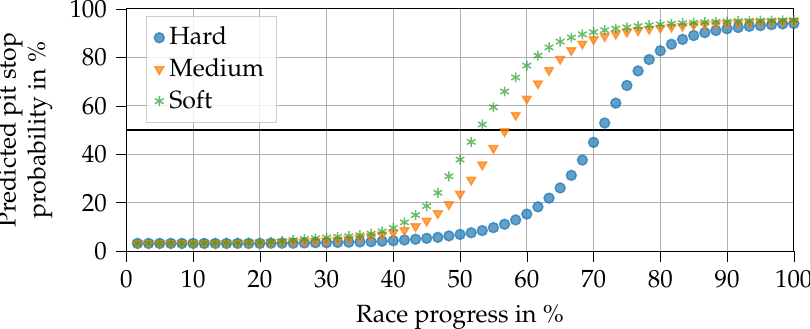
Figure 9. Progressions of pit stop probability predictions in an exemplary race when varying the relative tire compound, as outputted by the final trained hybrid NN. The horizontal line at a 50% probability level separates the no pit stop from the pit stop region.